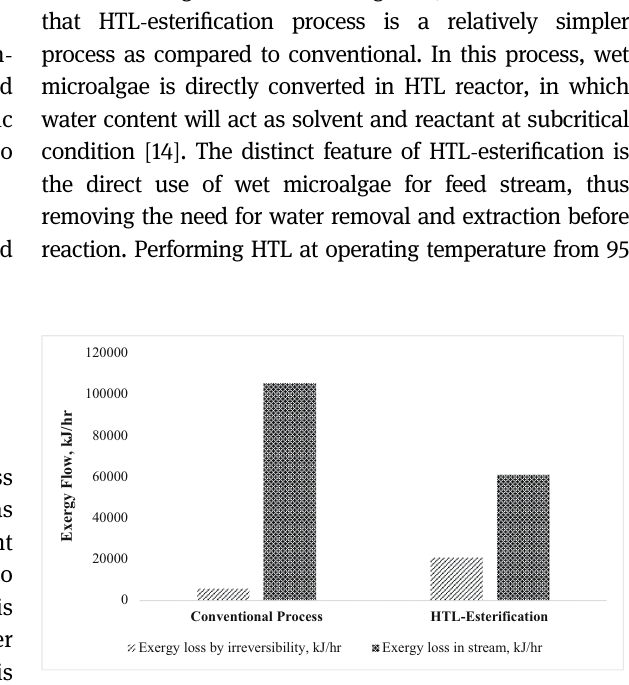
Figure 5: Biodiesel production process fl ow diagram of HTL - esteri fi cation process.